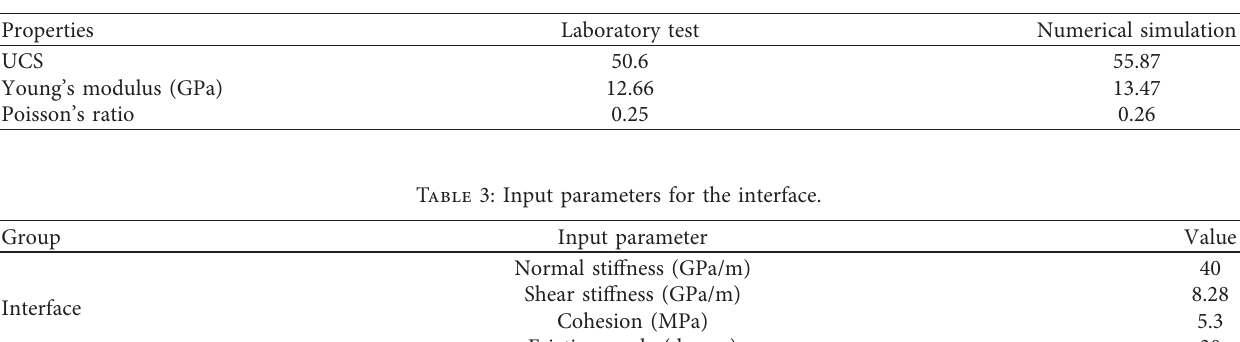
Figure 4: Circumferential displacement of the grid point at the right middle of the sample. Table 2: Comparison between the mechanical properties of the cement grout acquired from laboratory tests conducted by Moosavi [23] and calculated from numerical simulation.